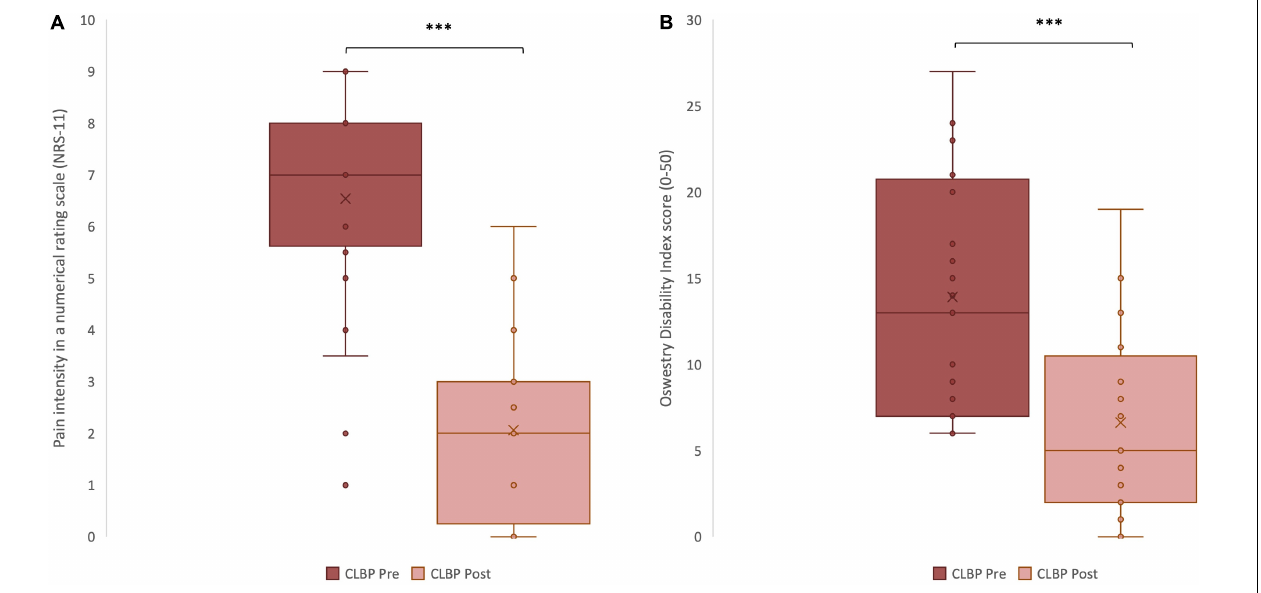
FIGURE 3 | Clinical variables measured in chronic low back pain (CLBP) patients, pre- and post-treatment. (A) Pain intensity scores reported in a Numerical Rating Scale, from 0 to 10, pre- and post- treatment ∗∗∗ p < 0.001. (B) Disability scores reported in the Oswestry Disability Index questionnaire, from 0 to 50, pre- and post-treatment. The middle line represents the median and the x represents the mean. The upper and the lower lines of the box represent the first and third quartile respectively and the whiskers include all individual data points within 1.5 times the interquartile range. ∗∗∗ p <